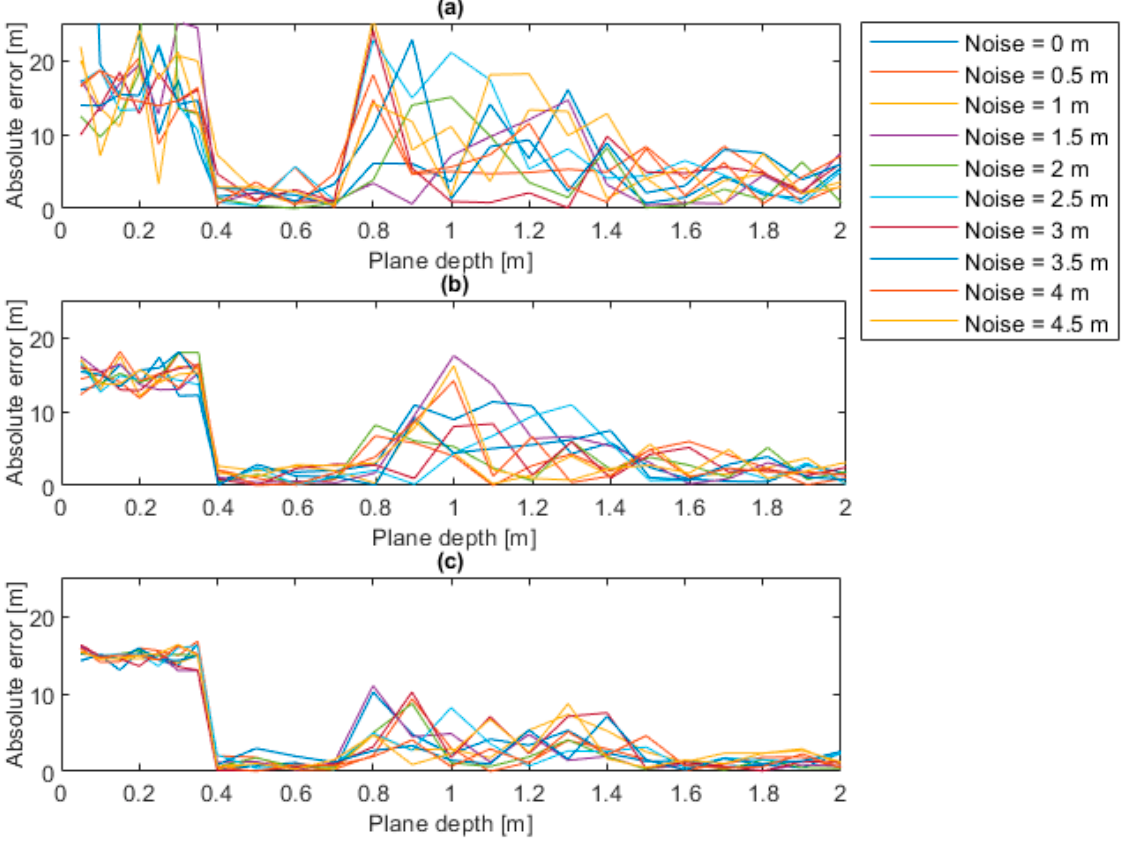
Figure Figure 10. Error trends for different noise levels ( a ) 1,000 iterations, ( b ) 10,000 iterations, ( c ) 100,000 iterations.